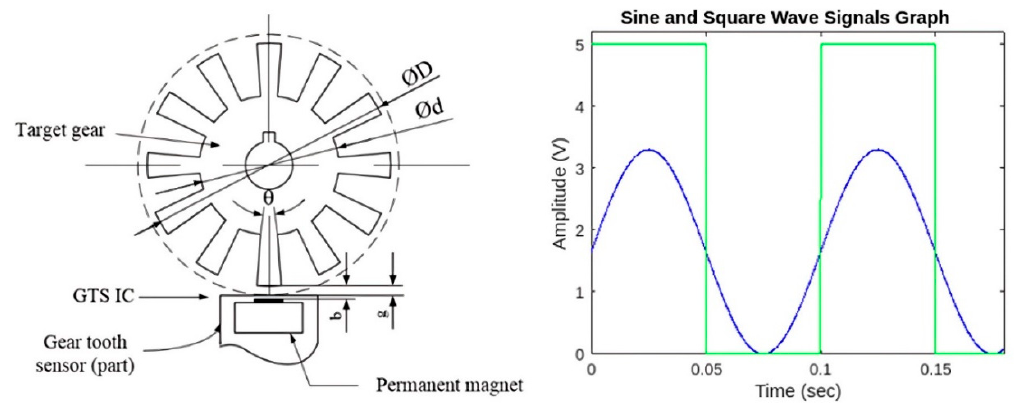
Figure 10. Hall effect gear tooth sensor CYGTS102DC and its output